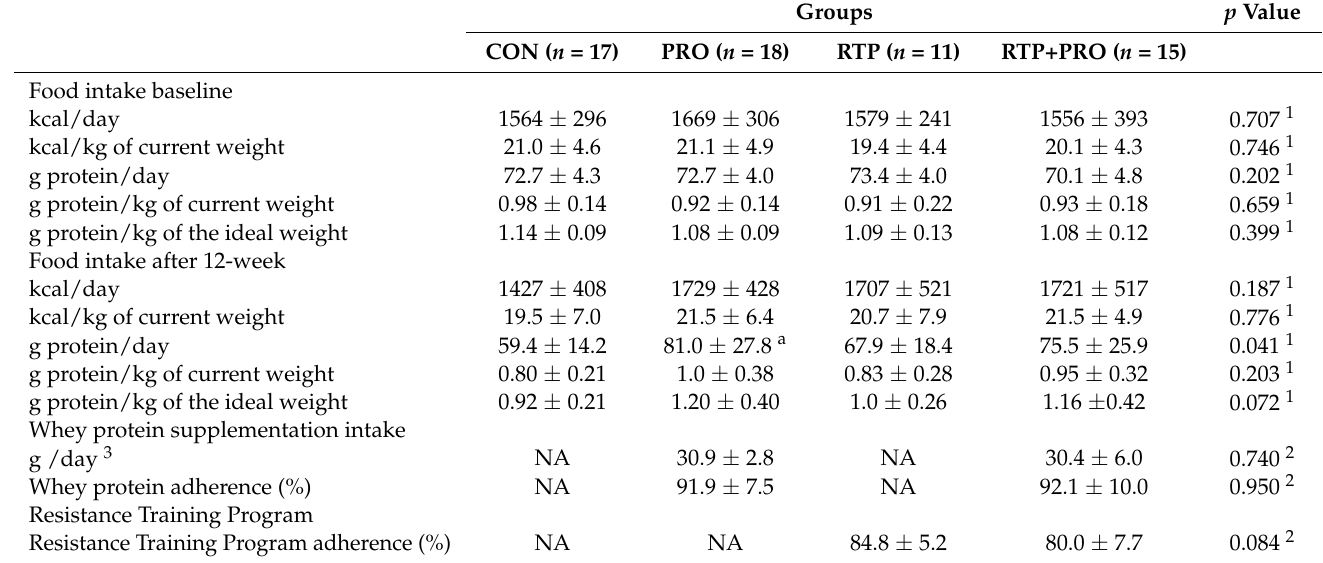
Table 2. Usual energy, protein intake, and study intervention adherence of individuals in the mid-to- late postoperative period after